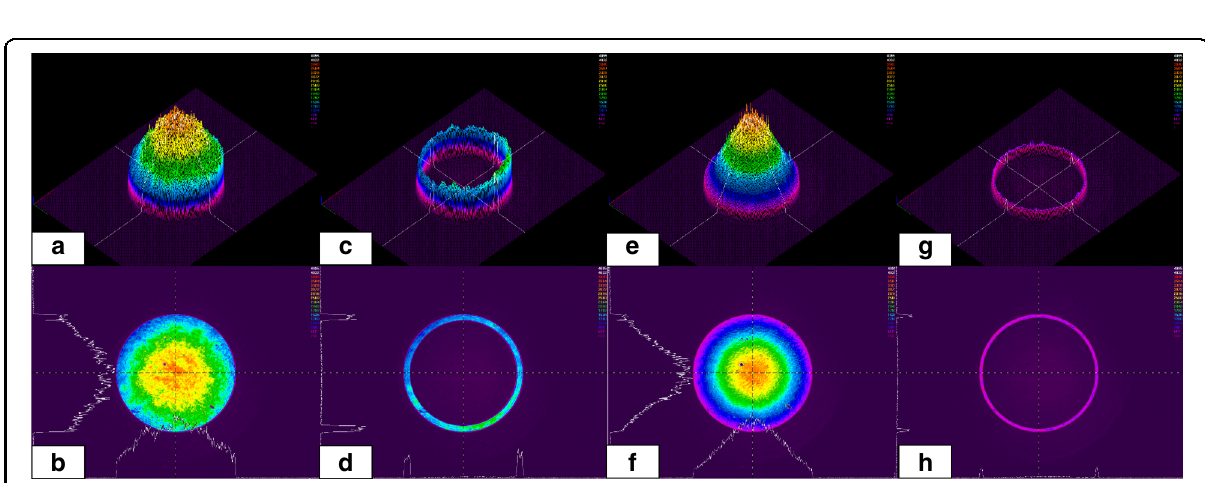
Fig. 12 Experimental measurement result of laser beam pro fi les before and after beam shaping. Comparison of collimated a , b original full aperture Gaussian beam, c , d original annular Gaussian beam, and e , f shaped full aperture Gaussian beam, g , h shaped annular Gaussian